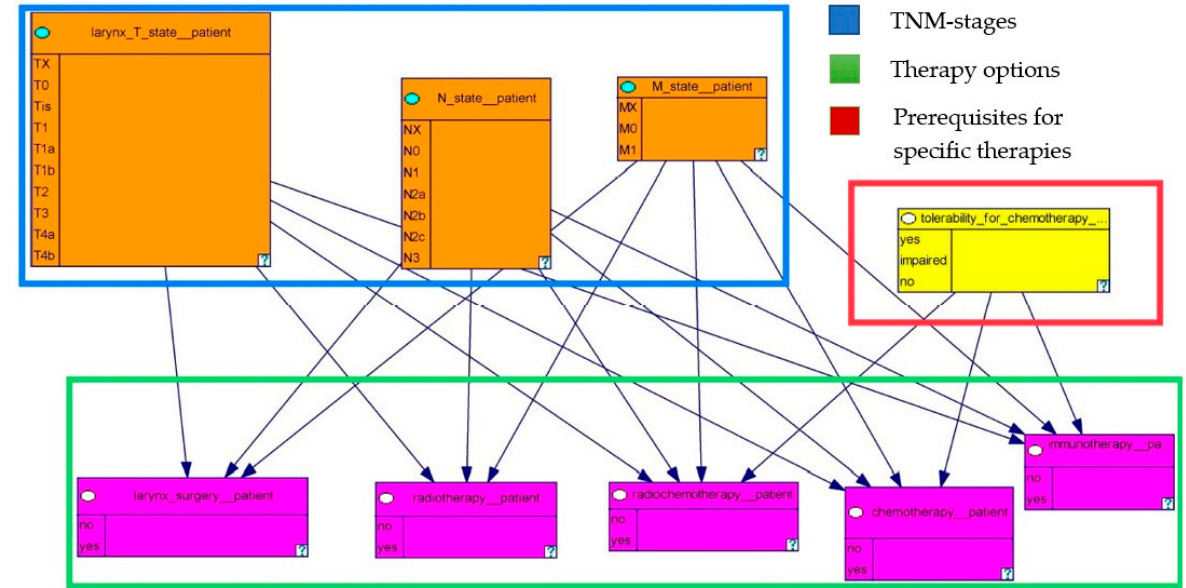
Figure 4. The therapy decision model grouped into the different categories.